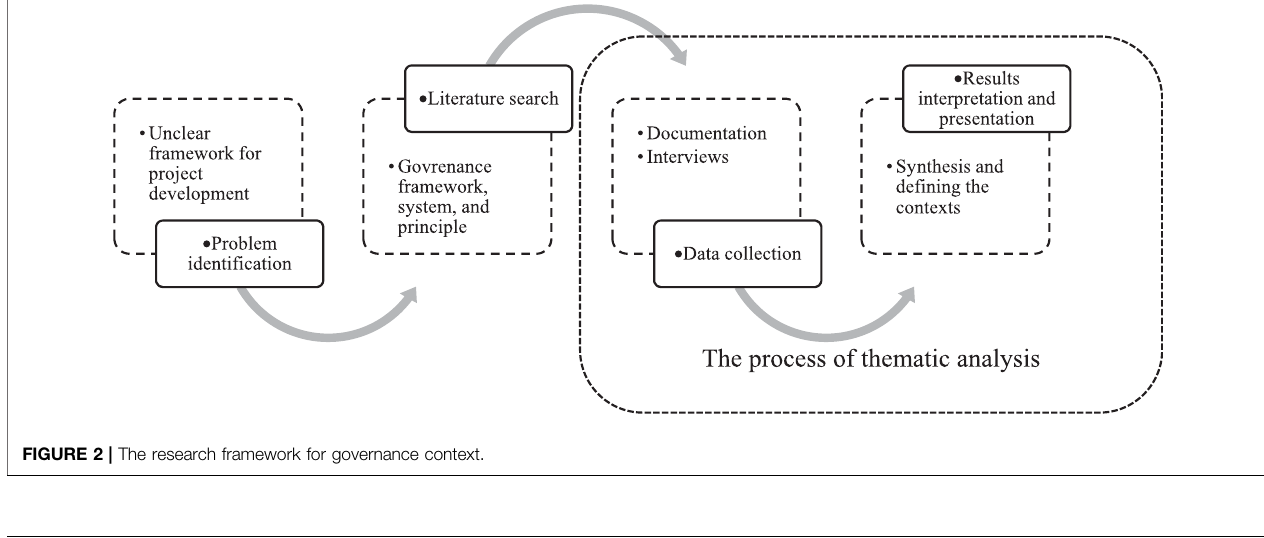
TABLE 1 | The front-end assurance tools of major public projects in six OECD countries. Six OECD Concept Countries assurance/decision